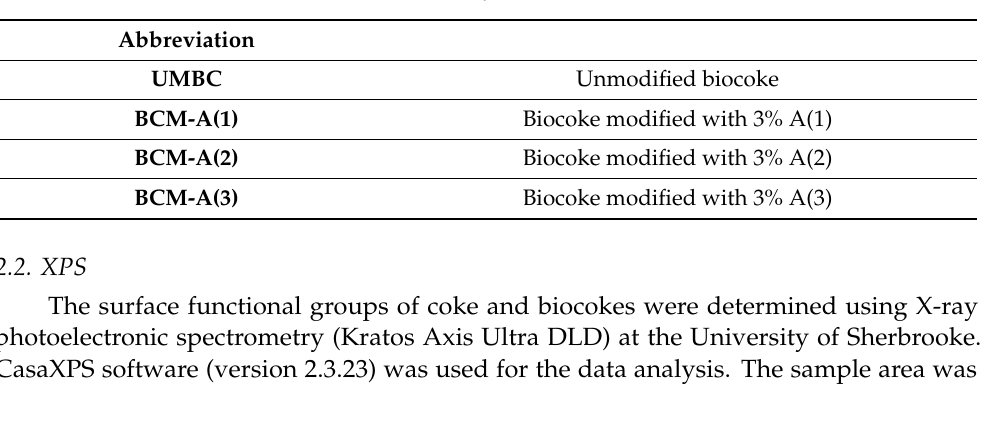
Table 1. Additives and biocokes used in this